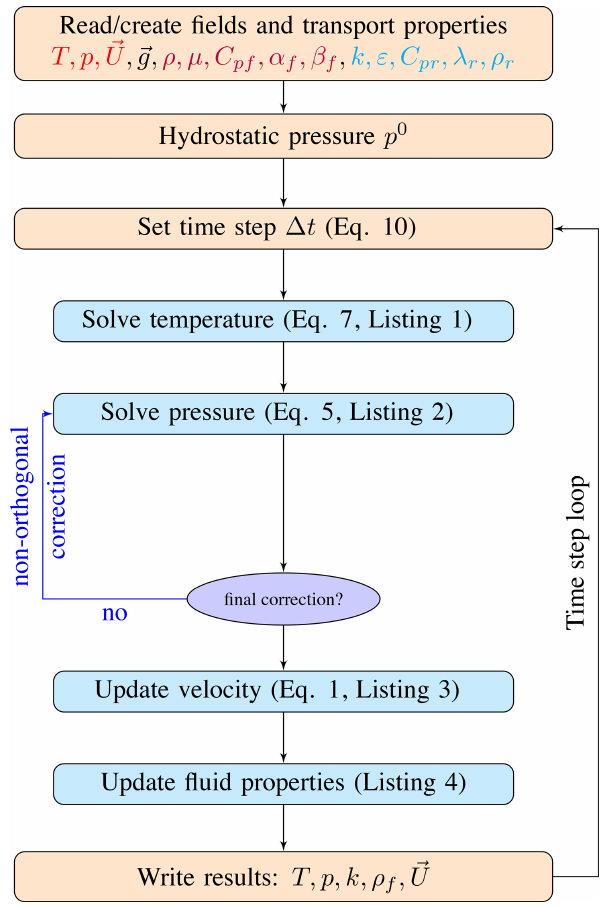
Figure 2. Schematic of the sequential